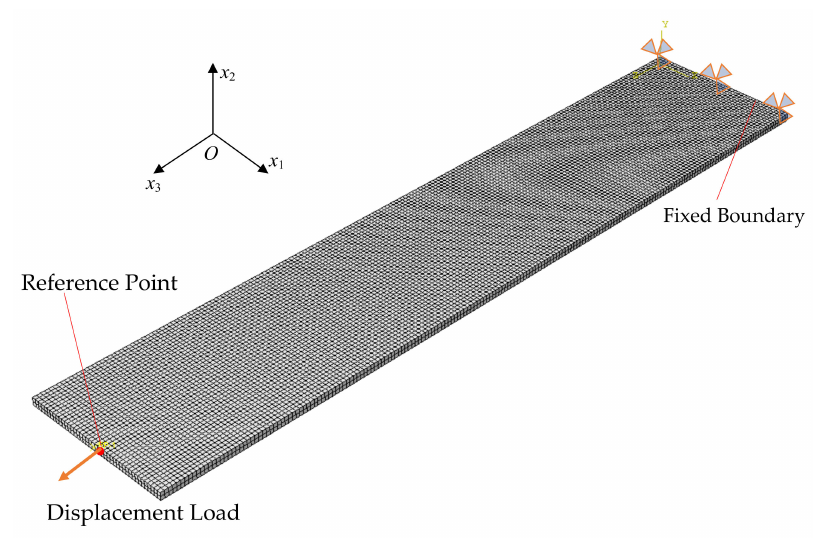
Figure 5. Nominal stress–strain curve under uniaxial tensile.